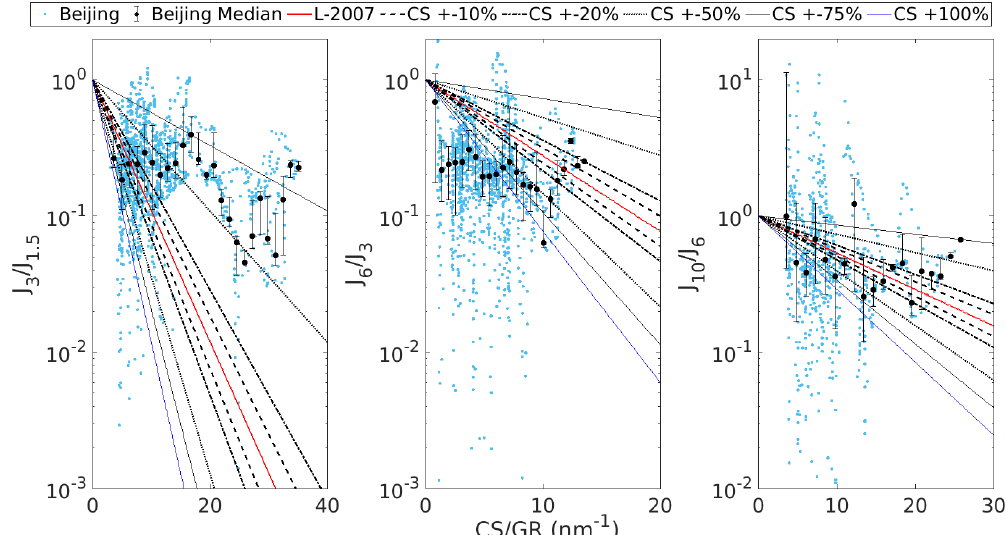
Figure 10. Survival probabilities from 1.5 to 3nm ( J 3 /J 1 . 5 ), from 3 to 6nm ( J 6 /J 3 ), and from 6 to 10nm ( J 10 /J 6 ) as a function of the ratio of condensation sink and growth rate (CS / GR). Survival probabilities based on the Lehtinen et al. (2007) (L-2007) equation with varying error of CS are presented. The observed survival probabilities from Beijing, China, are shown with their median values marked in black.